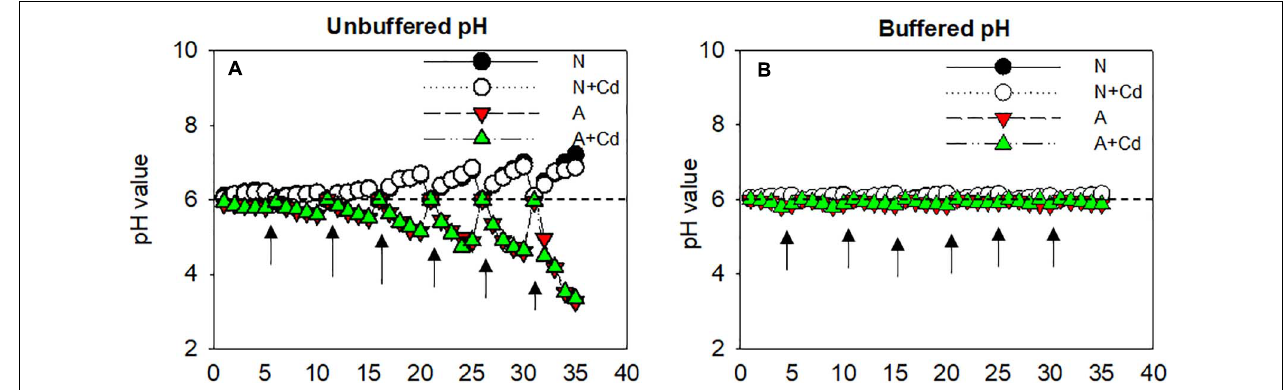
FIGURE 1 | Changes of pH values in the growth medium as affected by nitrate and ammonium in the presence or absence of Cd under unbuffered (A) or buffered (B) pH condition. N, nitrate; N + Cd, nitrate with Cd; A, ammonium; A + Cd, ammonium with Cd. Arrows represented time points of renewing nutrient solution which was changed every 5